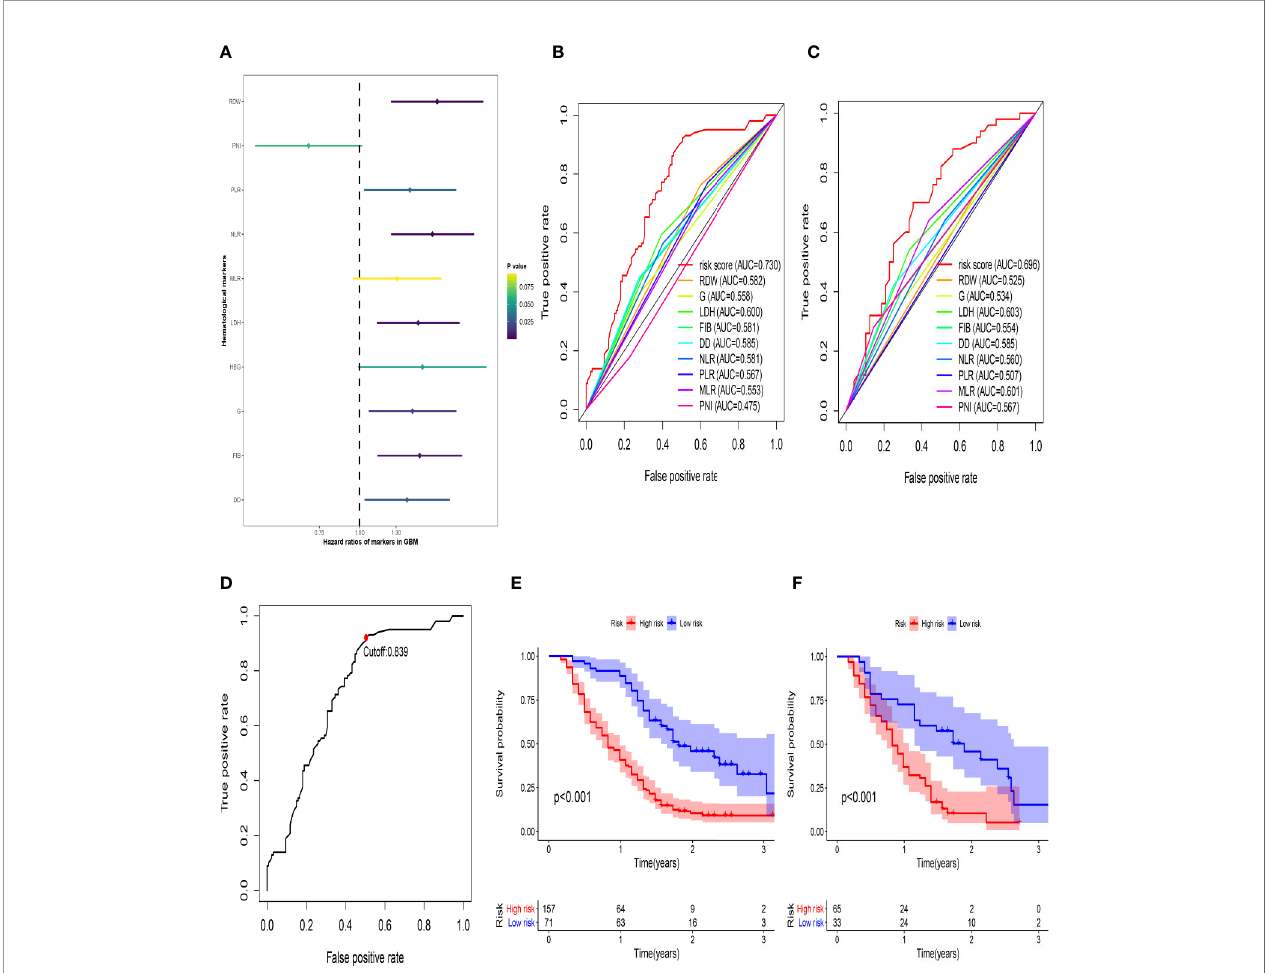
FIGURE 1 | The development of the HRS. (A) Univariate Cox regression analysis of the initially hematological markers. The color of the horizontal lines represents the correlation P-value. (B) The build results of the HBRPSS were shown in the form of ROC curves at 1-yr in the training group; (C) The veri fi cation results of the HBRPSS were shown in the form of ROC curves at 1-yr in the validation group; (D) The optimal cut-off value of HRS calculated by the analysis of ROC curve; (E) Kaplan – Meier curves of overall survival according to HRS-risk groups in the training group; (F) Kaplan – Meier curves of overall survival according to HRS-risk groups in the external validation